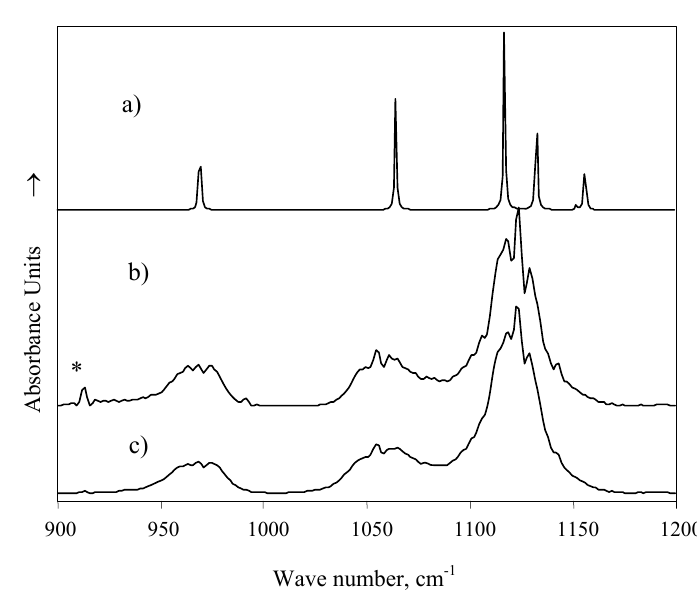
Fig. 3 IR absorption spectra of propene SOZ: a) theoretically (B3LYP 6- 311++G(3df, 3pd)) calculated spectra of the most stable O-O half-chair equatorial conformer; b) and c) experimental spectra of gaseous sample at 220 K and 295 K, respectively. ∗ - denotes propene spectral